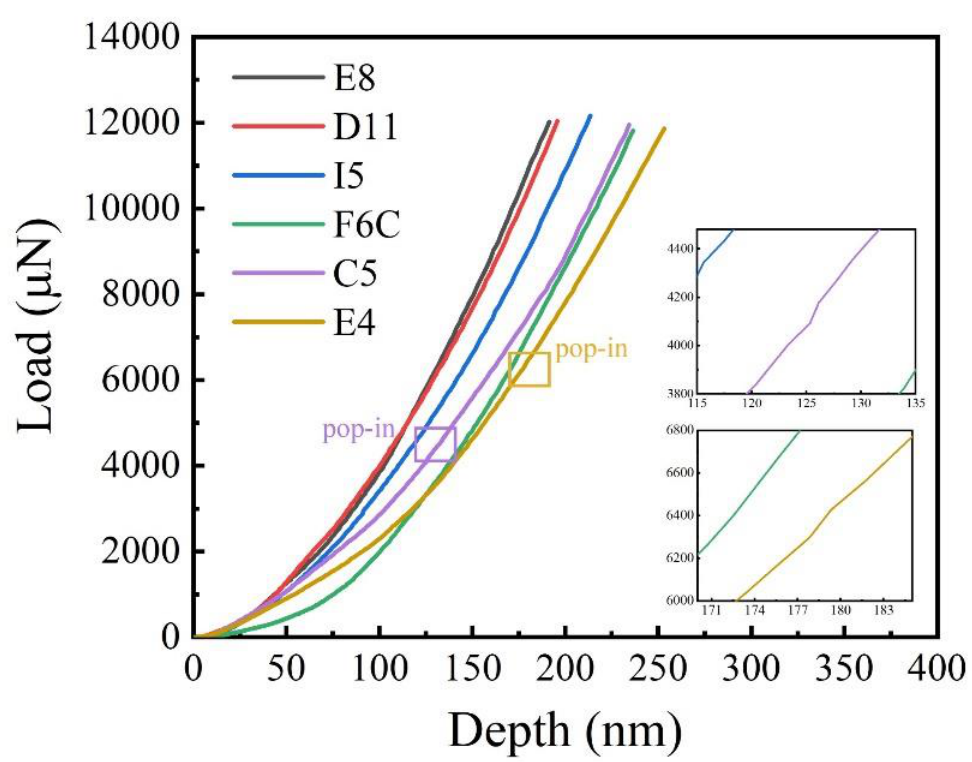
Figure 9. Typical load–displacement curves of ZrMoTaW film and the enlarged inset shows the “pop-in” phenomenon for Zr 18 Mo 18 Ta 36 W 28 and Zr 29 Mo 27 Ta 26 W 18 .